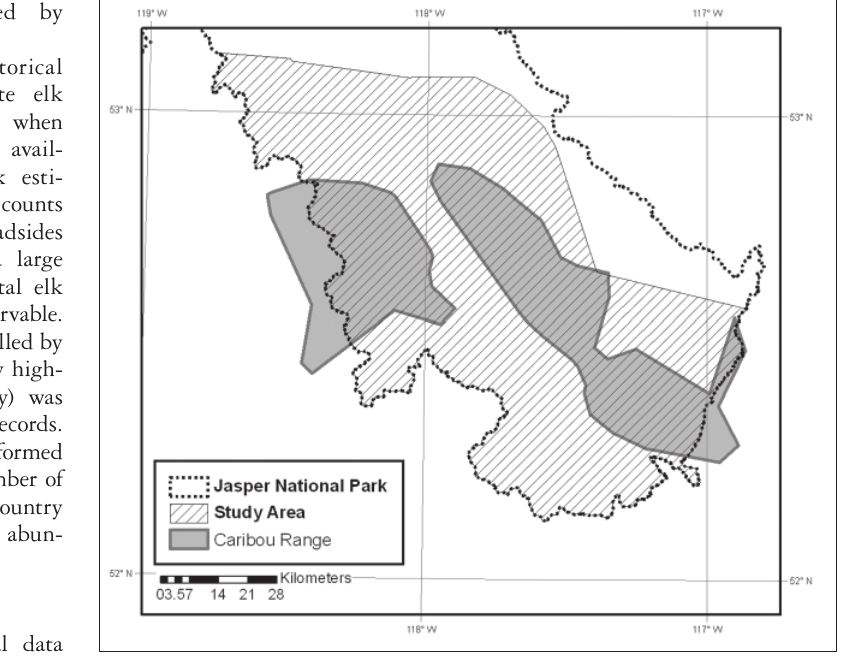
Fig. 2. Caribou and wolf research study area in Jasper National Park as defined by caribou range and associated wolf pack